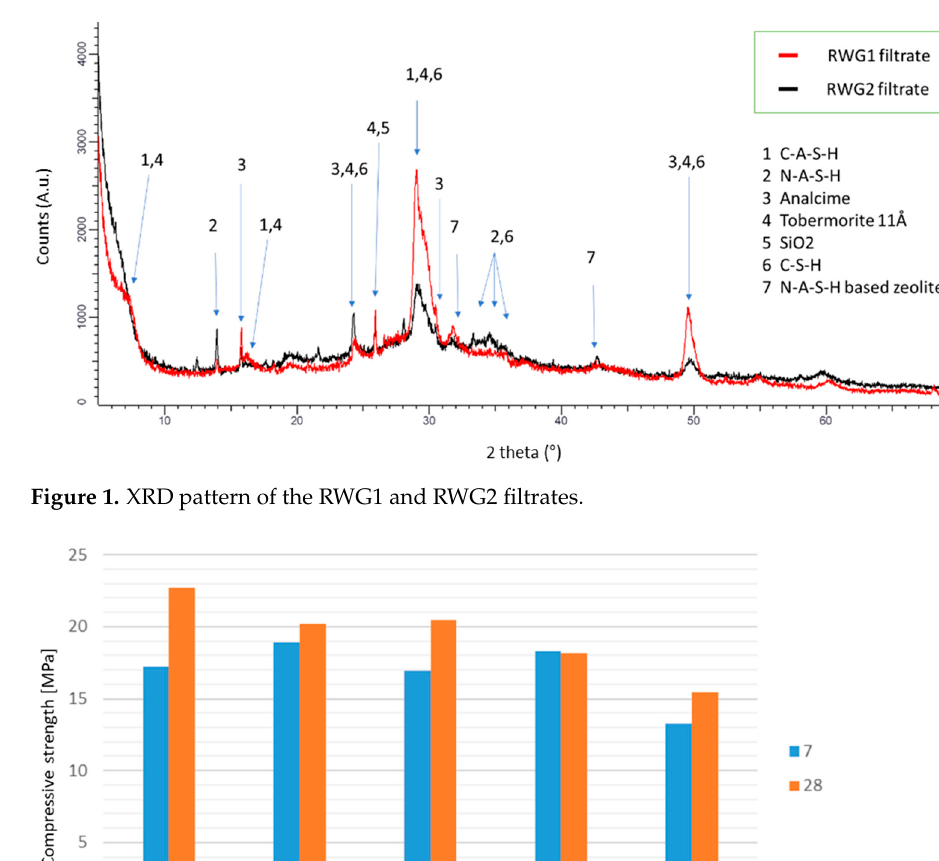
Figure 1. XRD pattern of the RWG1 and RWG2 filtrates.